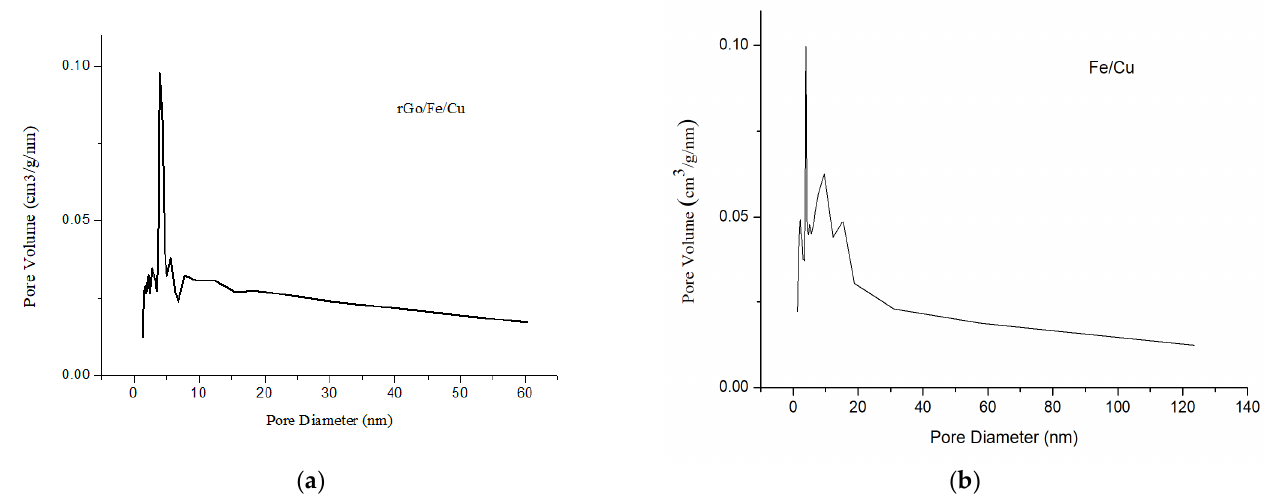
Figure 10. BJH pore size distribution curves of the ( a ) Fe/Cu nanoparticles and ( b ) rGO/Fe/Cu nanocompounds.